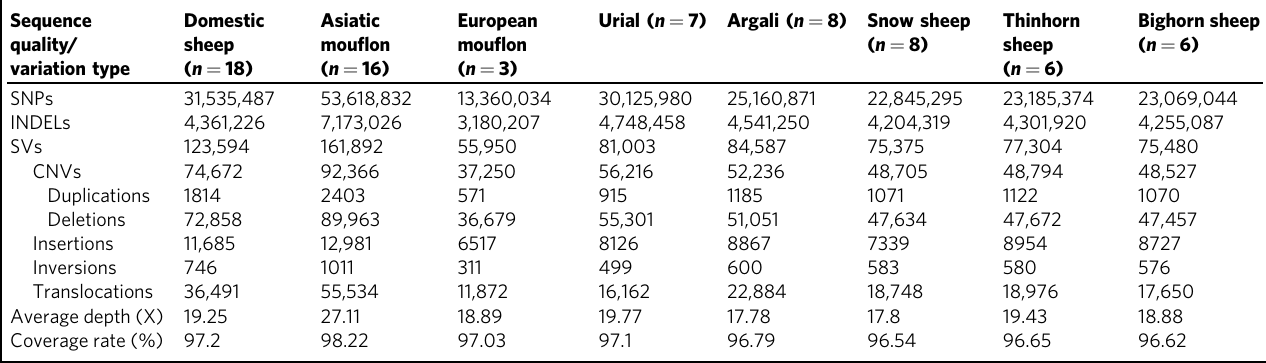
Table 1 Summary information of whole-genome variations identi fi ed in Ovis